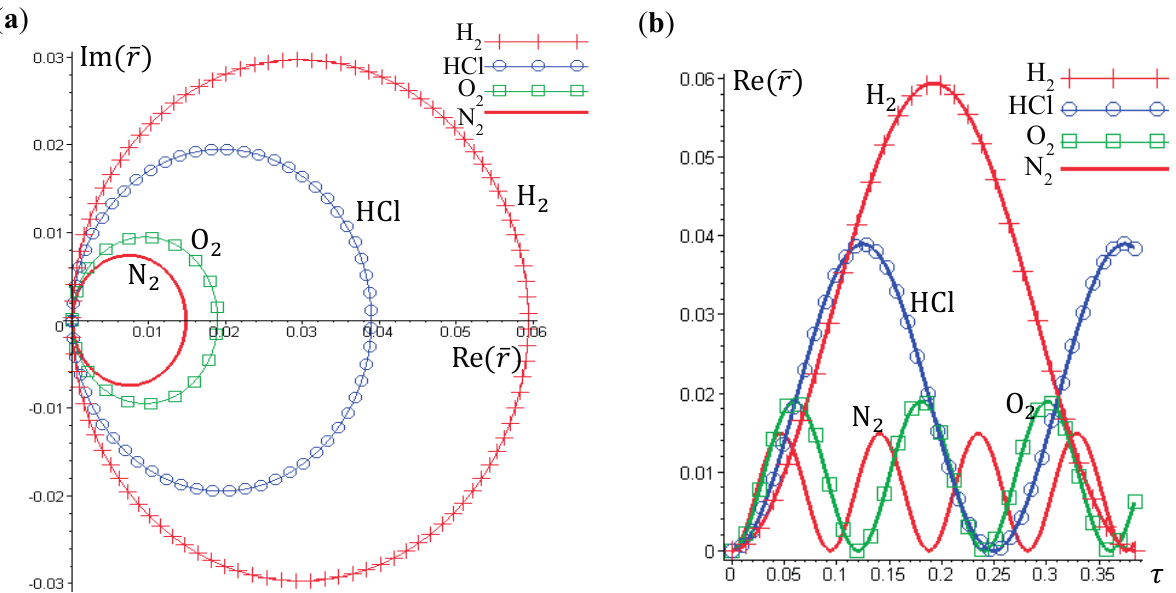
Figure 3. ( a ) The ground-state quantum trajectories solved from Equation (4.4) for the four types of diatomic molecules on the complex plane of (cid:1870)̅ . The complex trajectories are closed contours circulating around their respective equilibrium positions (cid:1870)̅ of Re((cid:1870)̅((cid:2028))) give the periods of vibration as (cid:1846)(cid:3364) and (cid:1846)(cid:3364) = 0.0941 , from which the vibrational frequencies (cid:1858) = 1/(cid:1846) = ℏ(cid:2010) (cid:2870) /((cid:1839)(cid:1846)(cid:3364)) are (cid:2898) (cid:3118) computed and compared with the experimental data listed in Table